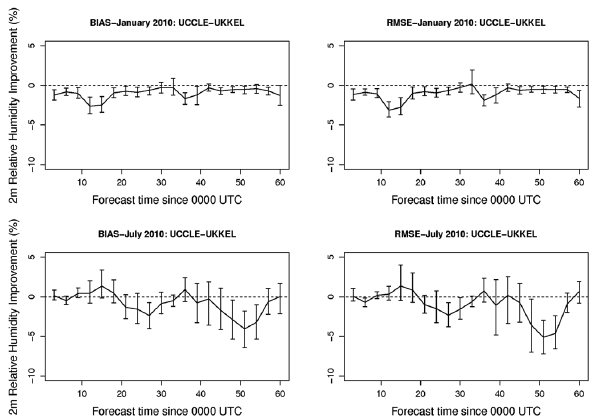
Fig. 6. The improvement in bias (left) and rmse (right) of the 2m relative humidity obtained when using SURFEX for Jan- uary (top) and July (bottom). The 95% confidence intervals for | bias |− bias | and rmse − rmse OPER + SFX OPER OPER + SFX OPER were calculated with the bootstrap